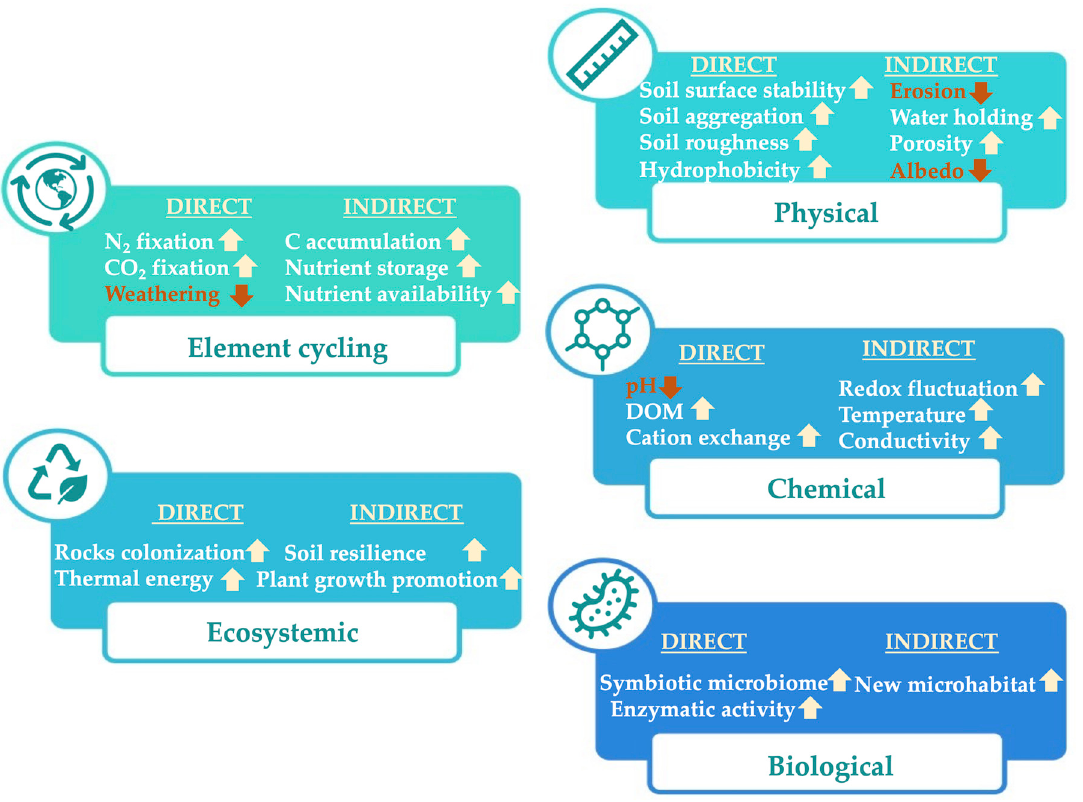
Figure 1. Effects of biocrusts on soil properties and element cycling. The direct and indirect effects are summarized according to their main mechanisms based on physical, chemical, biological, ecosystemic, and element cycling. The arrows before each point show an increase ( ↑ ) or decrease ( ↓ ) in the presence of biocrusts. Table 1. Preference of biocrust-composing microbial groups to climatic and edaphic conditions (nd = not determined). Organism Group